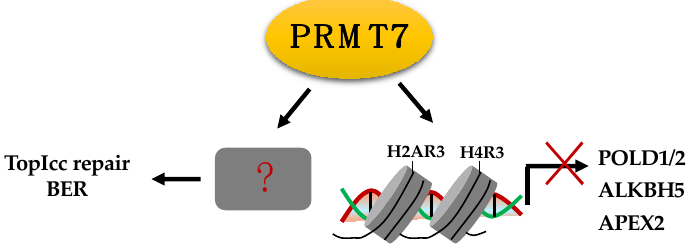
Figure 6. PRMT7 suppresses transcription of DNA repair genes by methylating H2AR3 and H4R3, and it is likely involved in TopIcc repair and BER via unknown mechanisms. ALKBH5, AlkB homolog 5; APEX2, Apurinic/apyrimidinic endodeoxyribonuclease; POLD1, DNA polymerase delta 1; POLD2, DNA polymerase delta subunit 2.